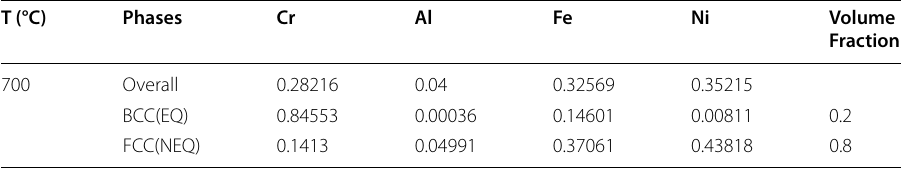
Table 5 Initial mole fractions in the FCC and BCC phase for the 1-D simulations T (°C) Phases